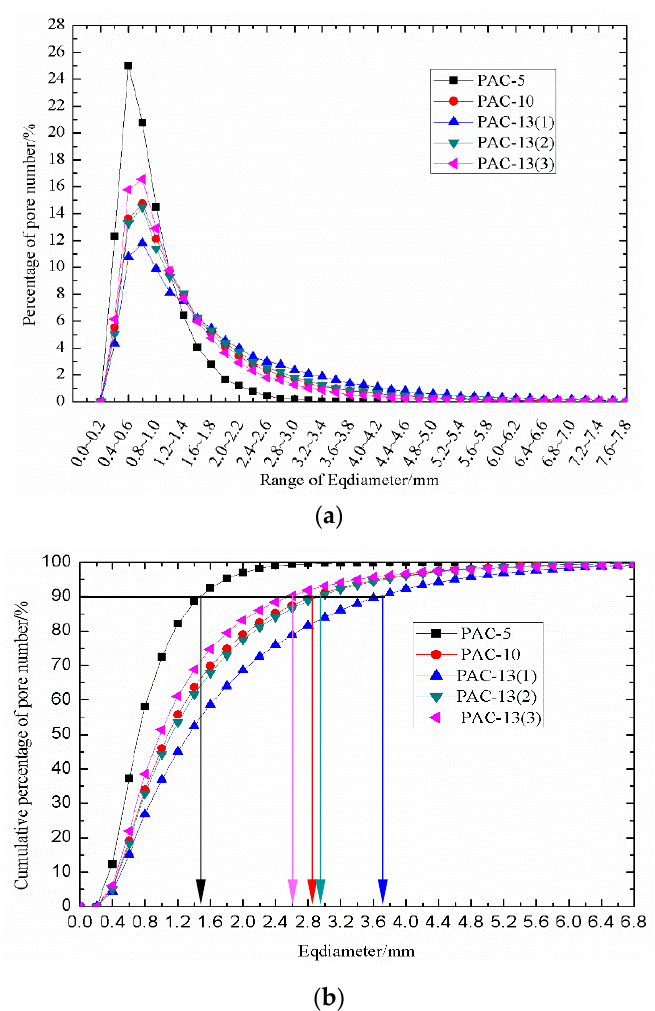
Figure 7. ( a ) Percentage of pore number in the range of Eqdiameter . ( b ) Cumulative percentage of pore number in range of Eqdiameter